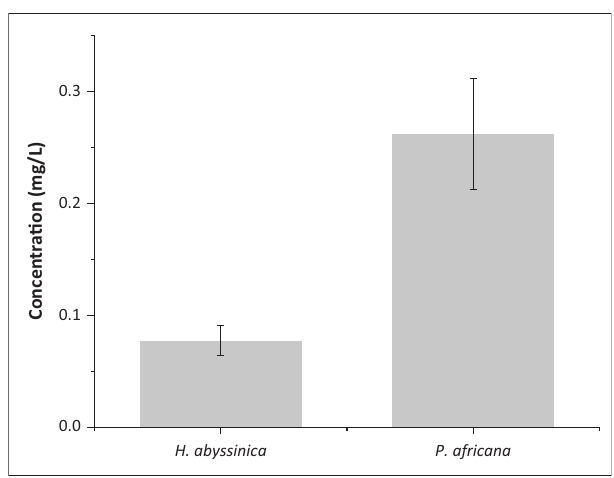
FIGURE 9: Phenolic content of methanolic extracts of Prunus africana and Harrisonia abyssinica. TABLE 7: Inhibition zone diameters (mm) for methanolic extracts of Harrisonia abyssinica and Prunus africana at different concentrations. Plant extract Gram-positive bacteria Fungus Gram-negative bacteria